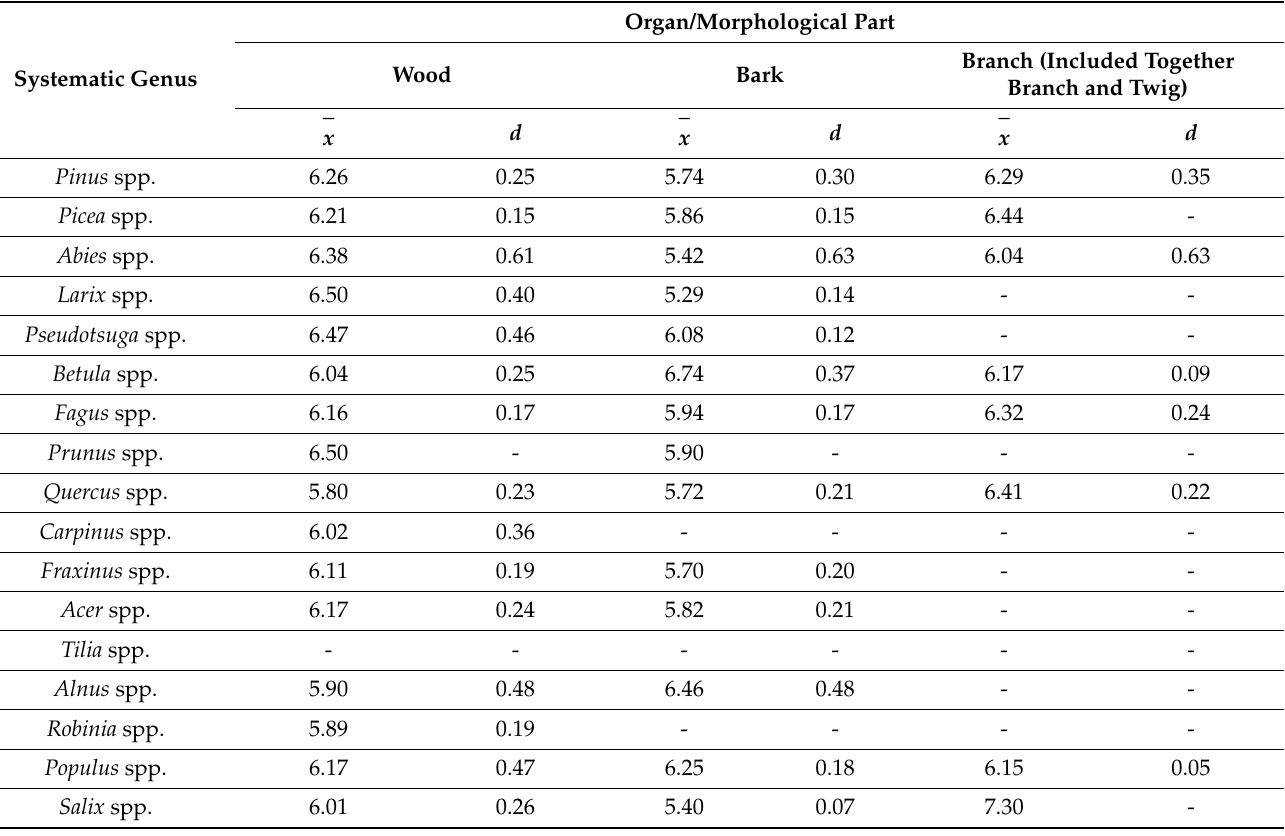
Table A17. Average value and average deviation of the hydrogen content (% d.m.) in various organs of particular systematic genera trees.